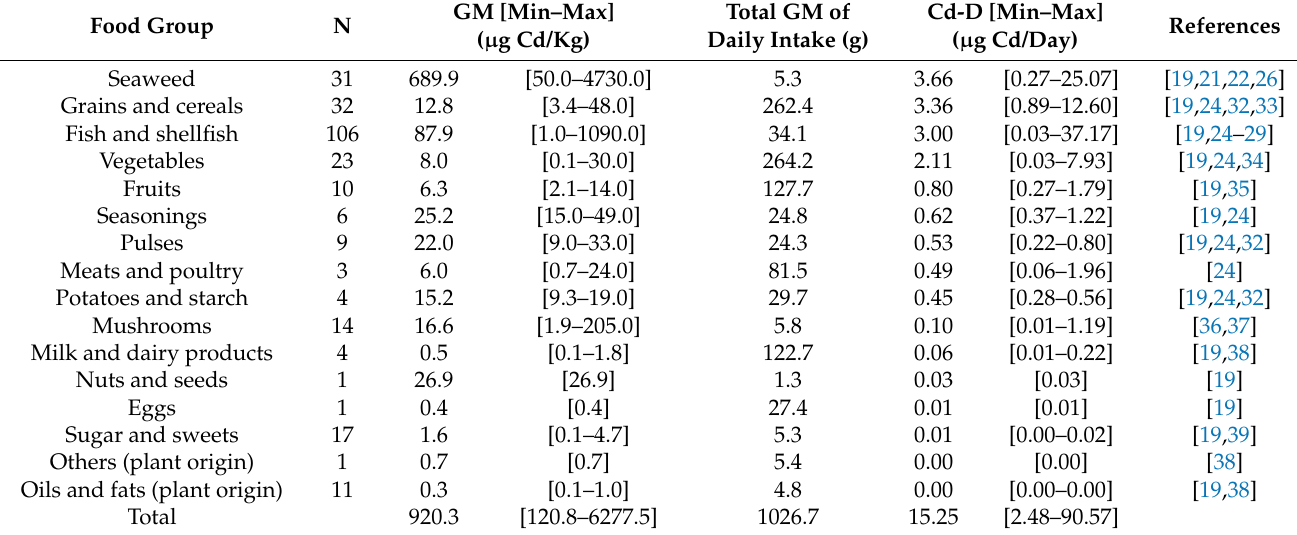
Table 3. Cd-exposure sources and probability of dietary Cd intake in Korean